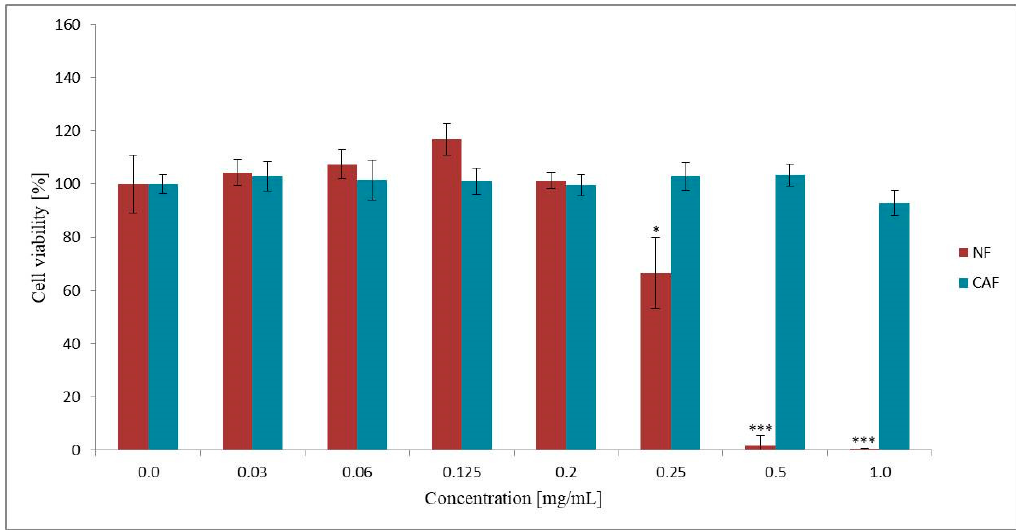
Figure 1. The effect of NF and CAF on Caco-2 cell viability. Results of the three independent replicates are presented as the mean ± SD. *** p < 0.001 and * p <